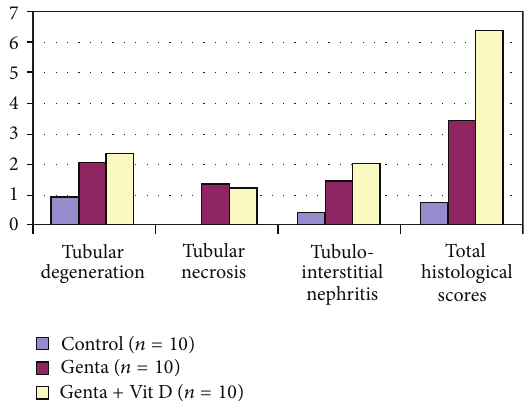
Figure 5: Renal histology. Pathological examination performed by semiquantitatively scored from 0 to